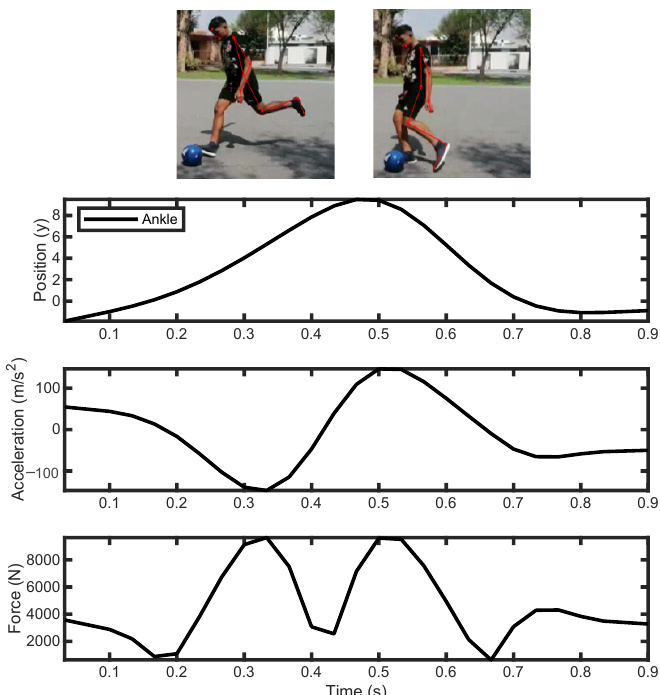
Figure 4. Temporal tracking of position, acceleration and estimated force of the left ankle of the volunteer during a football soccer kick. The insets at the top of the figure depict the sequence of movements that the volunteer was performing; before and after